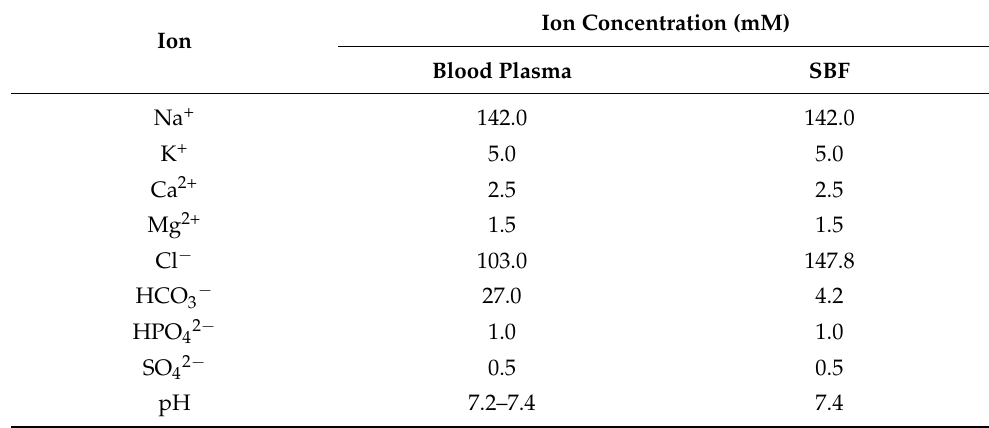
Table 2. Nominal ion concentration of SBF in comparison with human blood